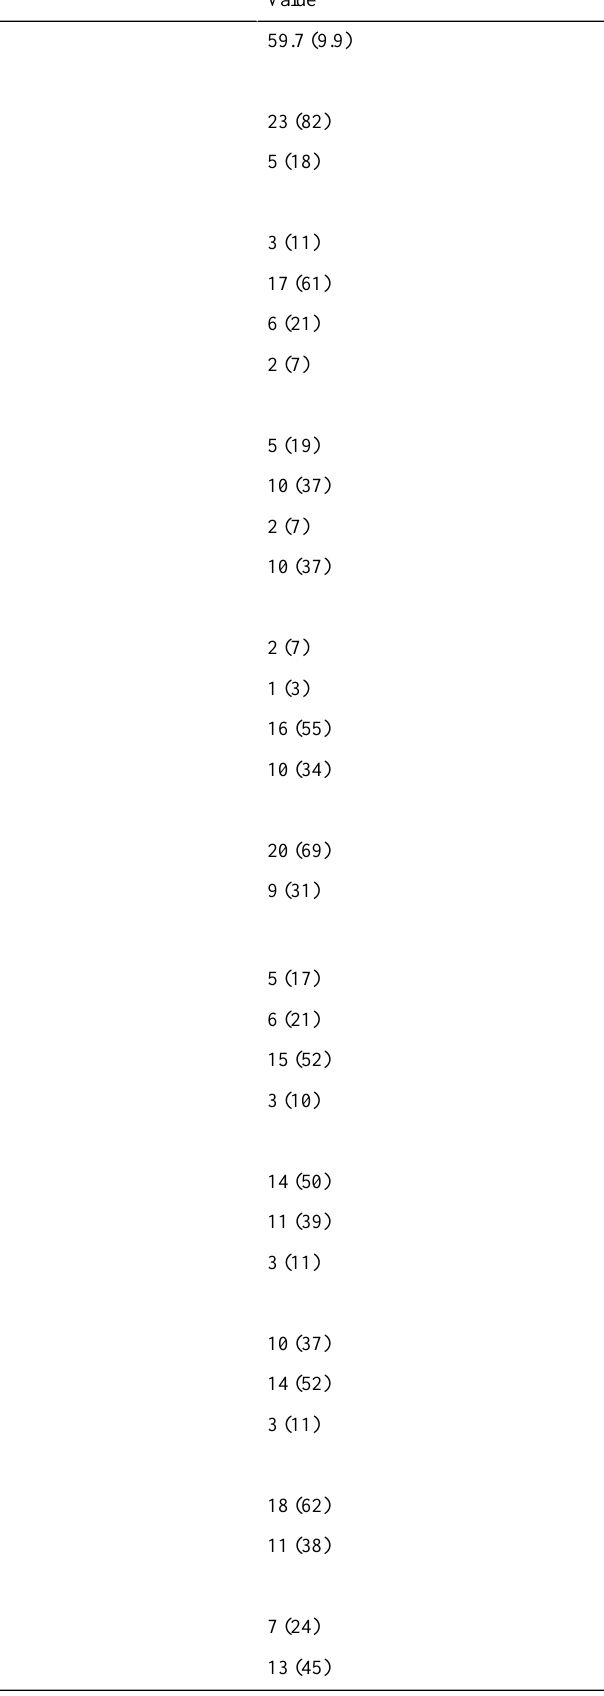
Table 3. Sociodemographic information of participating caregivers (N=30) a .